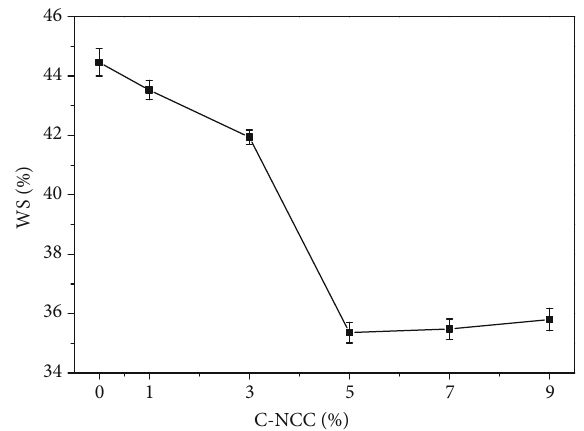
Figure 4: E ff ect of the C-NCC content on the WS of the composite fi lms.